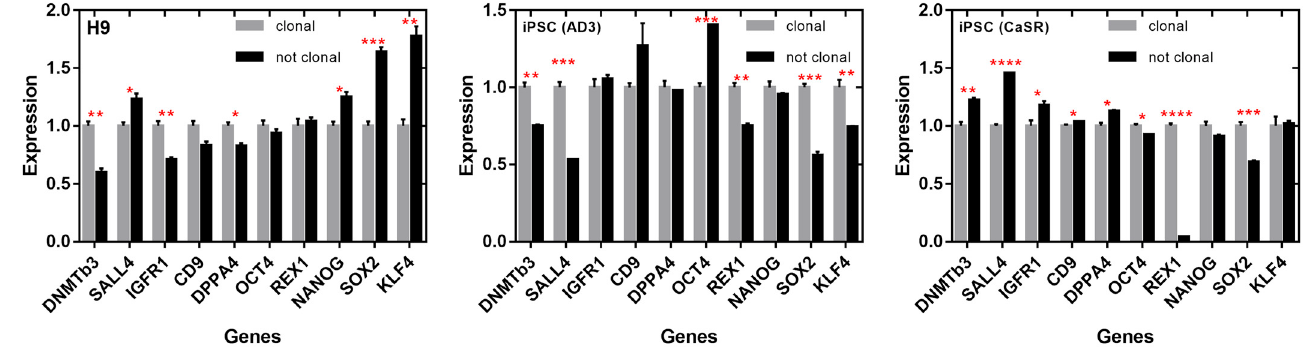
Figure 9. Relative expression of ten pluripotent genes in clonal (grey) and nonclonal (black) colonies measured for each cell line using qRT-PCR. Data are shown as means ± SEMs. Values were normalized to the mean expression in clonal colonies separately for each line. * p < 0.05; ** p < 0.01; *** p < 0.001; **** p < 0.0001.